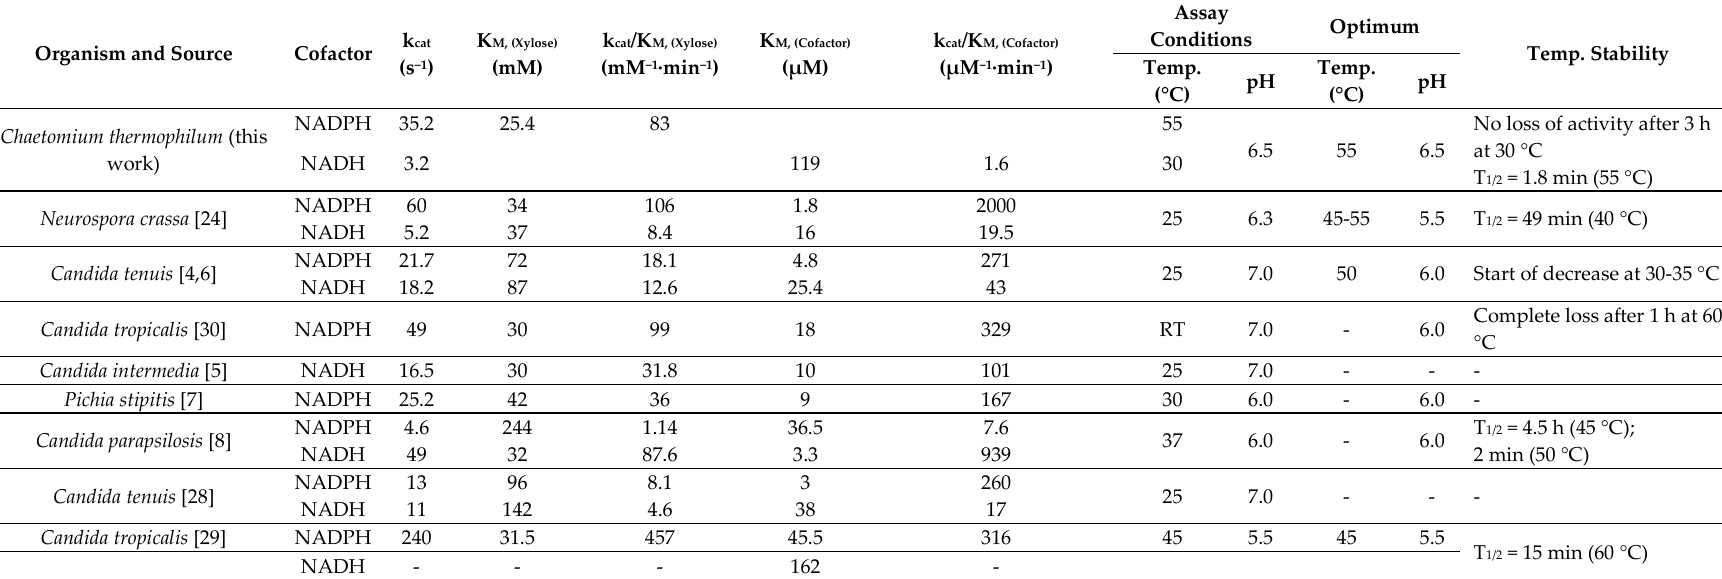
Table 6. Comparison of xylose reductases from various hosts: If possible, missing data were complemented with calculation based on the accessible values. In case of publication of multiple values for identical kinetic parameters, the mean value is shown in the